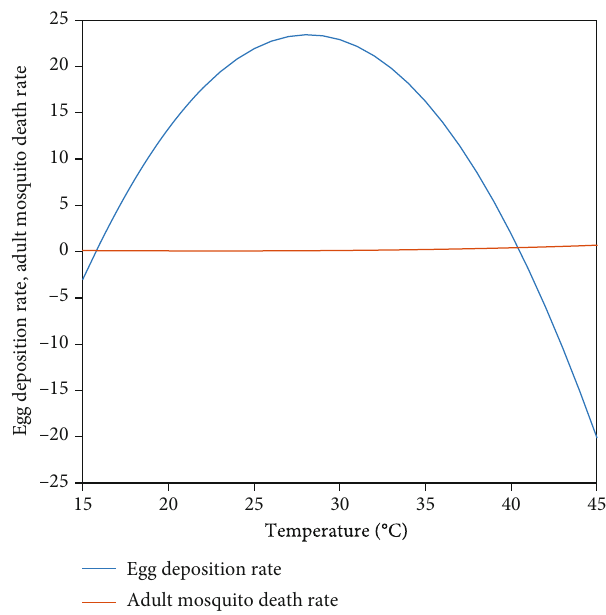
Figure 2: Egg deposition rate and adult mosquito death rate versus